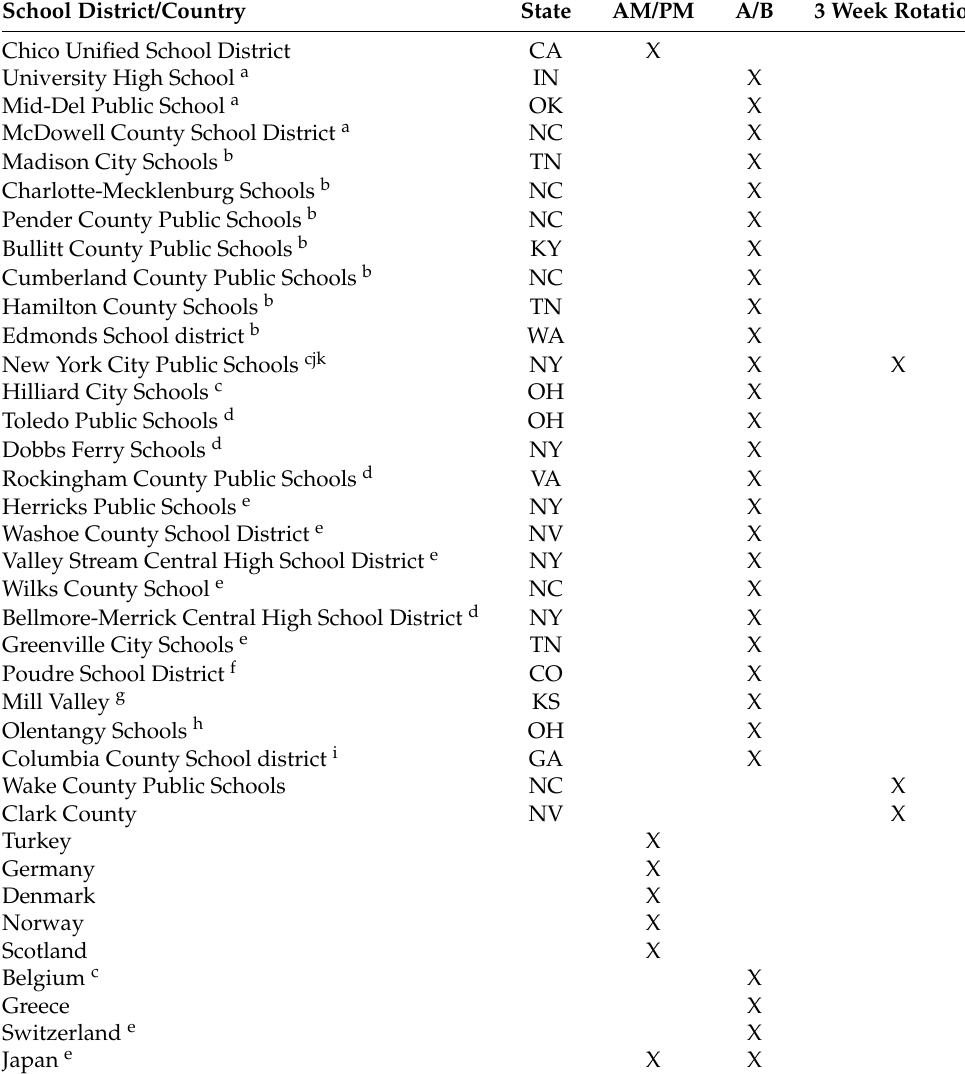
Table 1. School district and countries considered